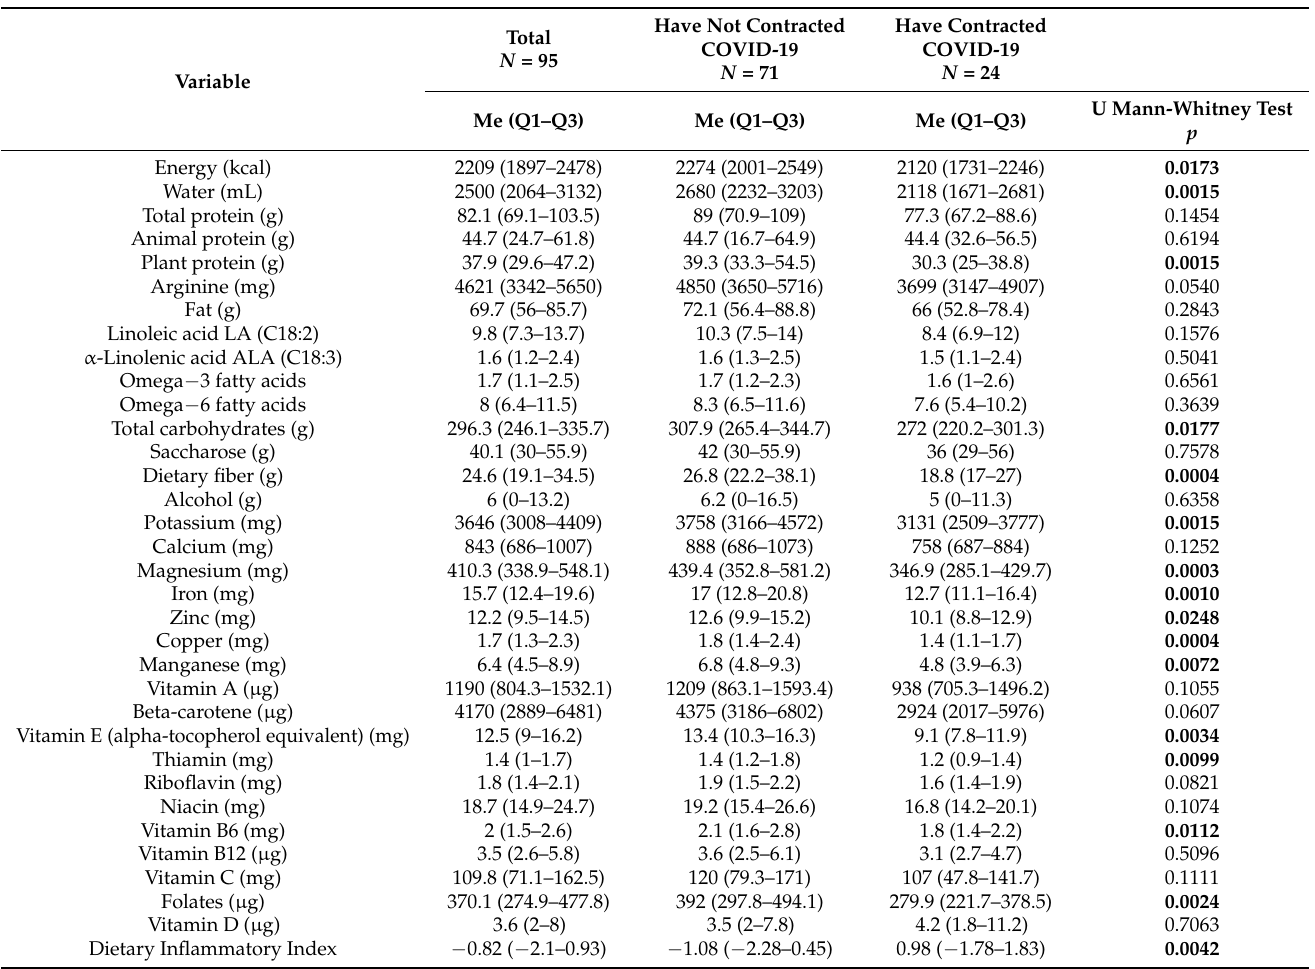
Table 2. Comparison of dietary intake and the Dietary Inflammatory Index between participants who contracted and those who did not contract COVID-19.